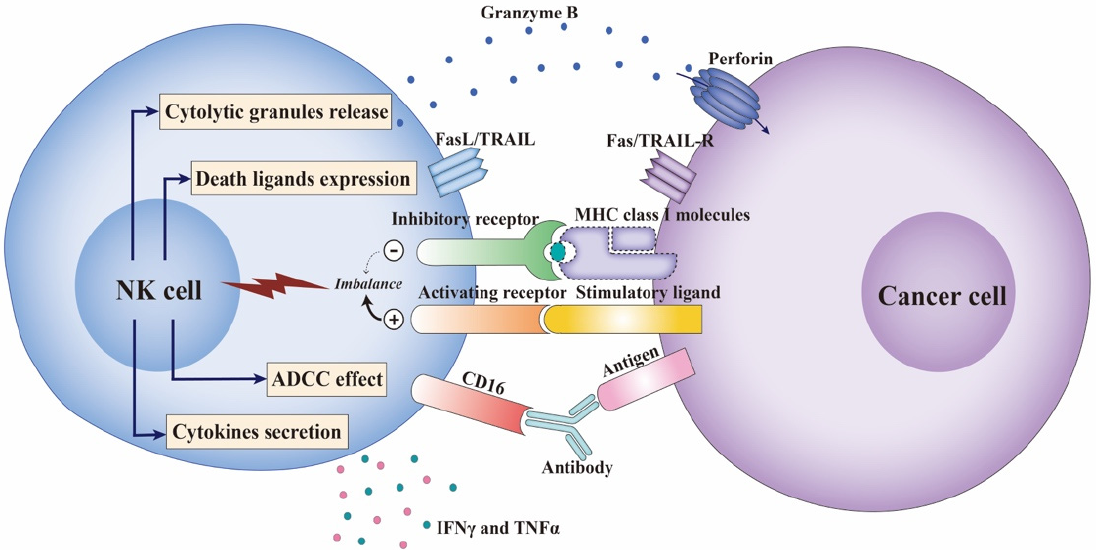
Figure 1. The function of NK cells in response to cancer cells. The activity of NK cells is regulated by the signal input from the activating and inhibitory receptors expressed on NK cells. Cancer cells upregulate stimulatory ligands for NK cell-activating receptors such as NKG2D and downregulate MHC class I molecules to avoid cytotoxic T cell killing, which breaks the balance and leads to NK cell activation. Activated NK cells rapidly synthesize and release cytolytic granules, perforin and granzymes, initiating cancer cell apoptosis. NK cells can also express death ligands, FasL and TRAIL, combined with Fas and TRAIL-R expressed on cancer cells, to mediate apoptosis. A specific function of NK cells in anti-cancer immunity is to exert ADCC by expressing CD16 to recognize antibody-coated cancer cells. In addition, as immunoregulatory cells, NK cells secrete a set of cytokines and chemokines, especially IFN- γ and TNF α , which could promote NK cell anti-cancer function and stimulate other maturation and activation of other lymphocytes. ADCC-Antibody-dependent cellular cytotoxicity; IFN- γ -Interferon-gamma; MHC-Major histocompatibility complex; NK cell-Natural killer cells; TNF α -Tumor necrosis factor-alpha; TRAIL-R-TNF-related apoptosis-inducing ligand.